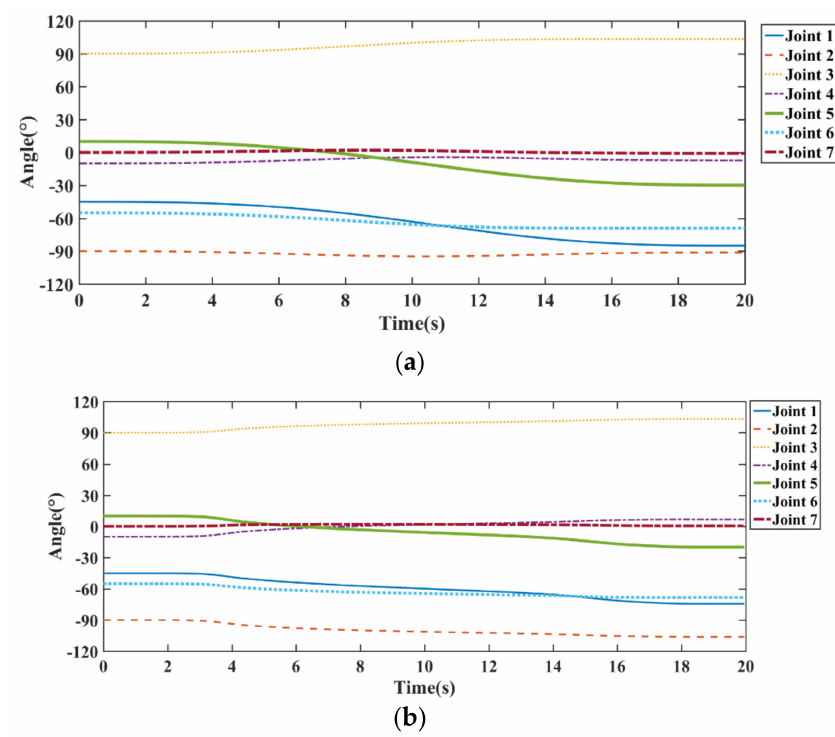
Figure 19. Joint angles of trajectories. ( a ) Without optimization, ( b ) With optimization.